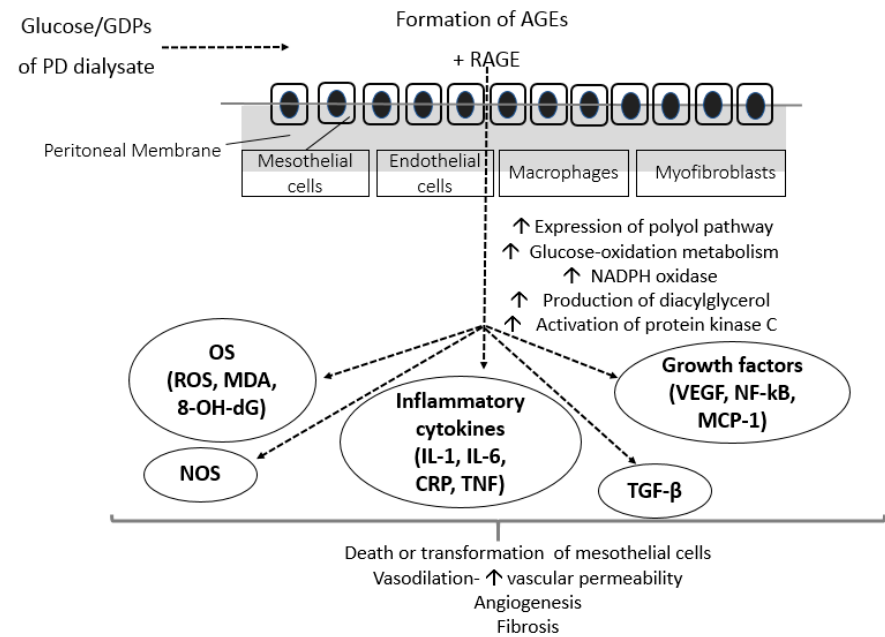
Figure 1. Effects of conventional hyperglycemic PD solutions on the peritoneum. AGEs, advanced glycation end-products; CRP, c-reactive protein; GDPs, glucose degradation products; IL, interleukin; MCP-1, monocyte chemoattractant protein-1; MDA, malondialdehyde; NADPH, nicotinamide adenine dinucleotide phosphate; NF-kB, nuclear factor kB; NOS, nitric oxide synthase; PD, peritoneal dialysis; RAGE, AGE-receptor; TGF- β , transforming growth factor β ; TNF, tumor necrosis factor; VEGF, vascular endothelial growth factor; 8-OH-dG, 8-hydroxy-2 ′ -deoxyguanosine.